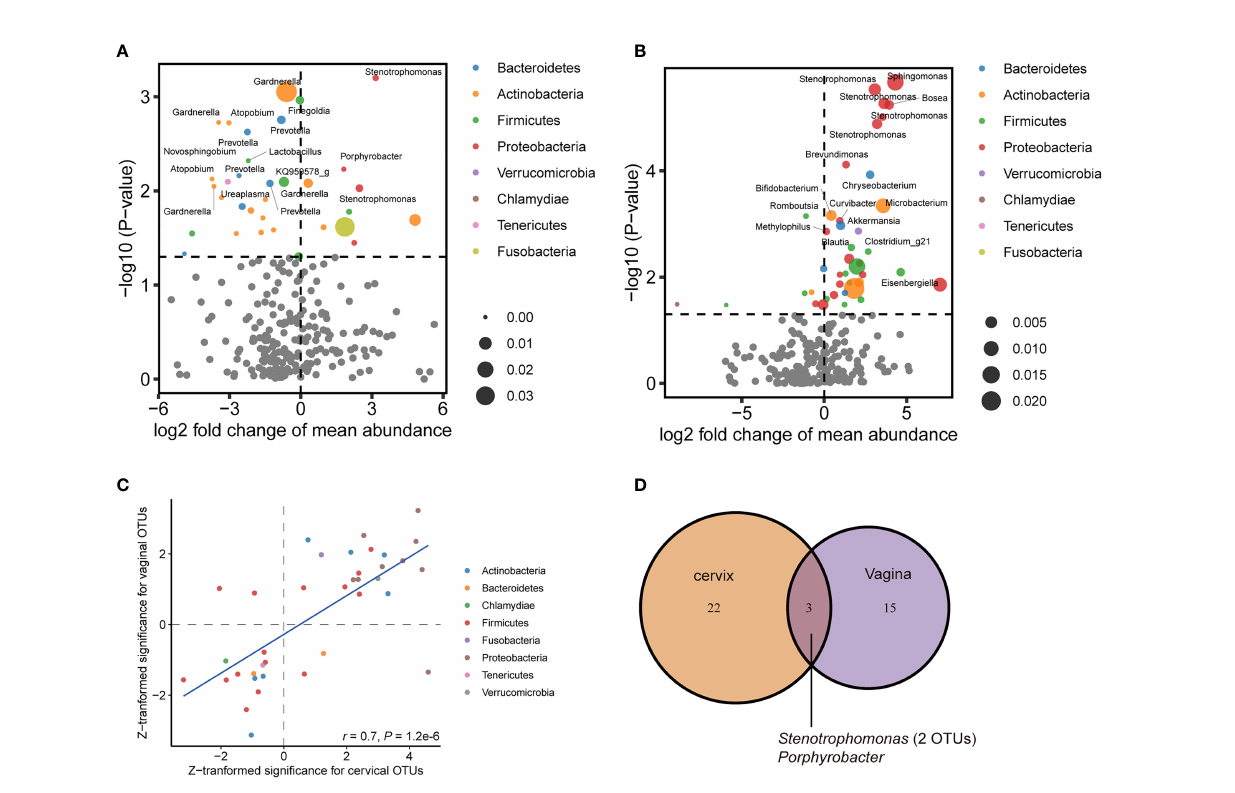
FIGURE 2 | Differential abundance of operational taxonomic unit (OTU) associated with cervical intraepithelial neoplasia (CIN) in the vagina and cervix. (A) Volcano plot showing perturbated OTUs in the vagina. (B) Volcano plot showing perturbated OTUs in the cervix. (C) Correlation of Z-transformed signi fi cance of top signi fi cant OTUs between the vagina and cervix. (D) Venn diagram showing shared signi fi cant ( p < 0.01) OTUs associated with CIN between the vagina and